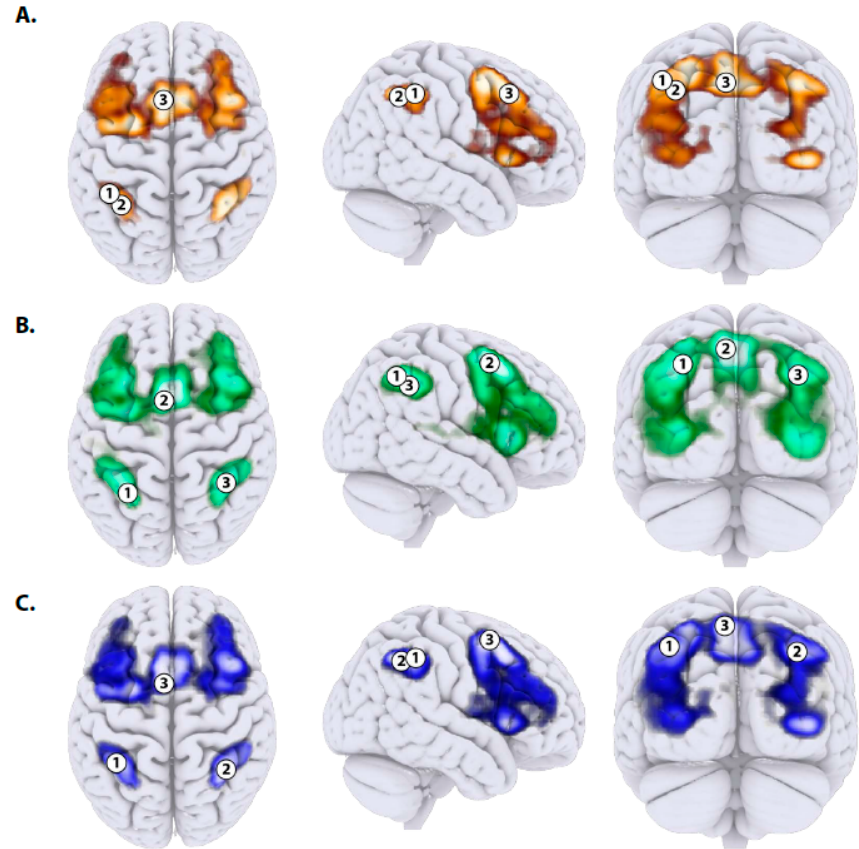
Figure 2. Contrast maps showing changes in brain activation associated with the correct identification of targets (‘Hits’, 3A), corrects rejection of distractors (‘Correct rejection’, 3B), and accuracy of N-back task performance (‘Correct vs. Incorrect’, 3C). Only the significant ROIs that survived the FDR correction are shown. ( A ) 1—superior parietal lobule; 2—inferior parietal lobule (SMG posterior); 3—superior frontal gyrus. ( B ) 1—superior parietal lobule; 2—superior frontal gyrus